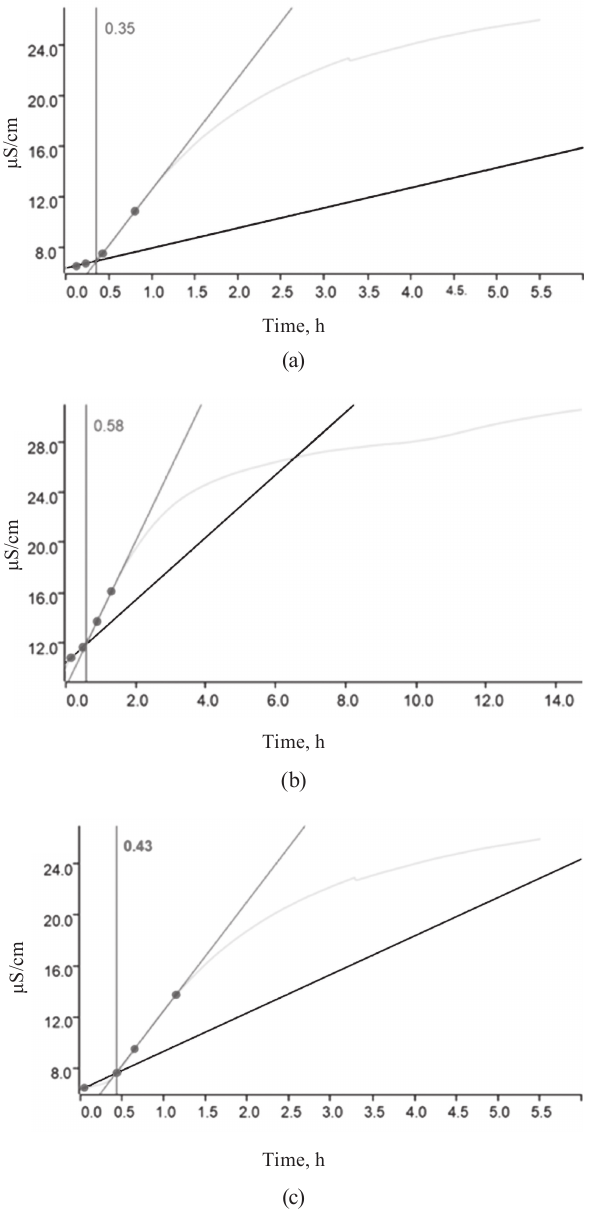
Figure 1 Oxidative stability of: (a) control, (b) GCE